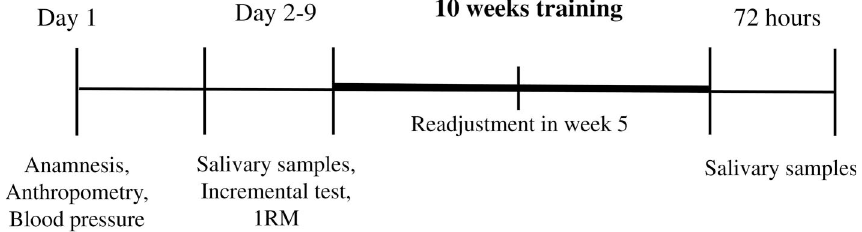
Figure 1 - Study design. 1RM: one maximum repetition